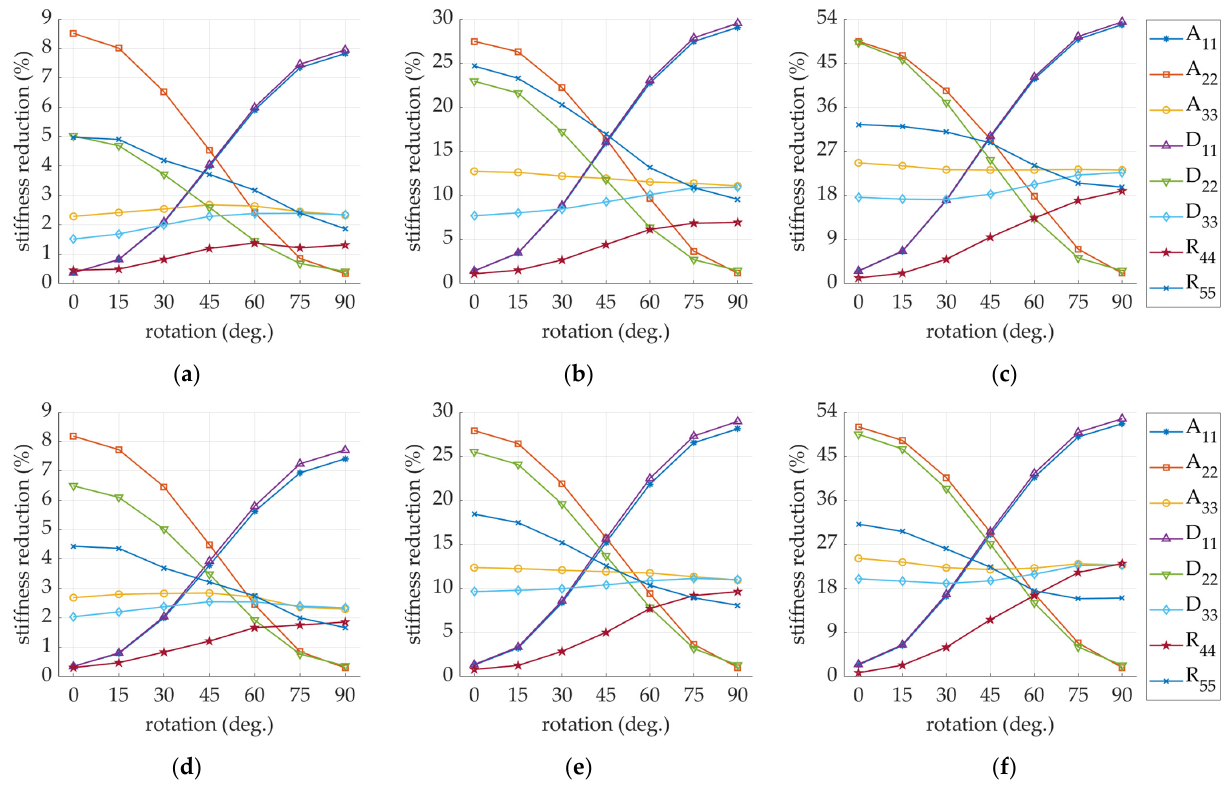
Figure 12. Stiffness degradation in sample: ( a ) SW-26; ( b ) SW-44; ( c ) SW-62; ( d ) DW-26; ( e ) DW-44; ( f ) DW-62. Table 8. The selected stiffnesses in SW models for different perforations and flute rotated by 15 degrees.